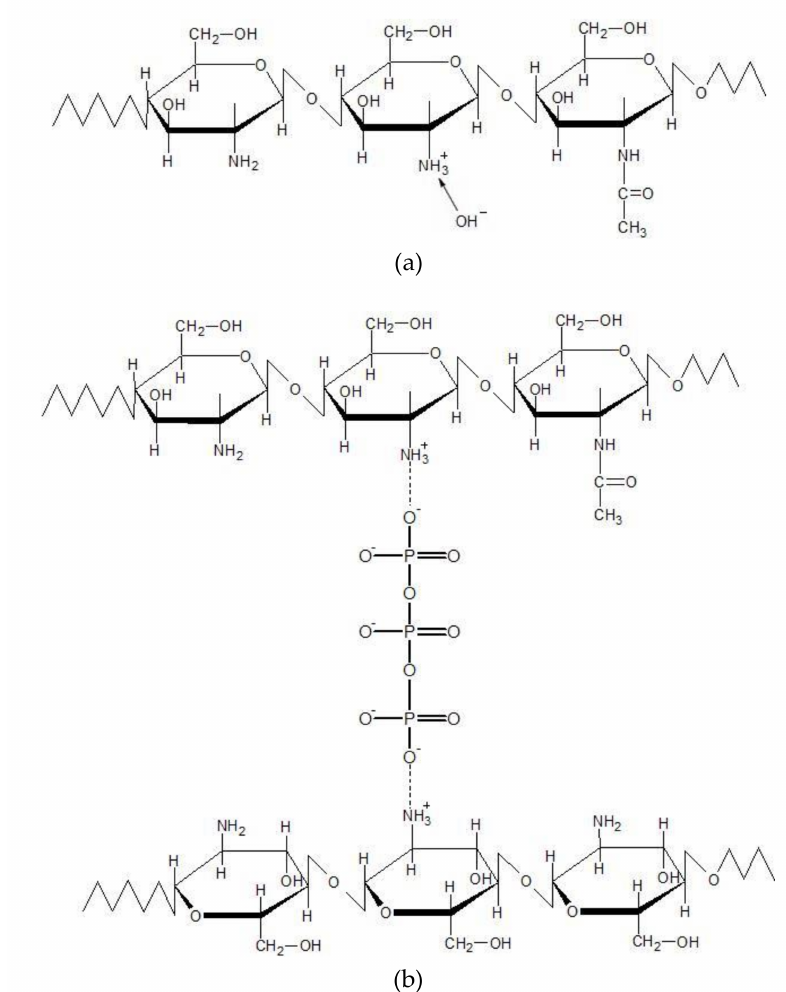
Figure 3. Representation of the P 3 O 5 − ( a ) deprotonation and ( b ) ionic